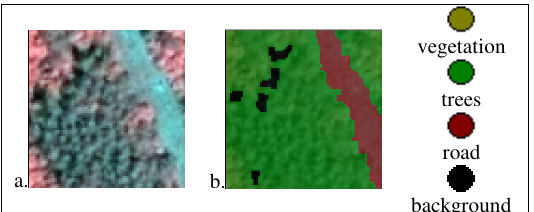
Figure 4. Quickbird-2 imagery, object-based classification results and classification classes for plot number = 22, stand number = 13.